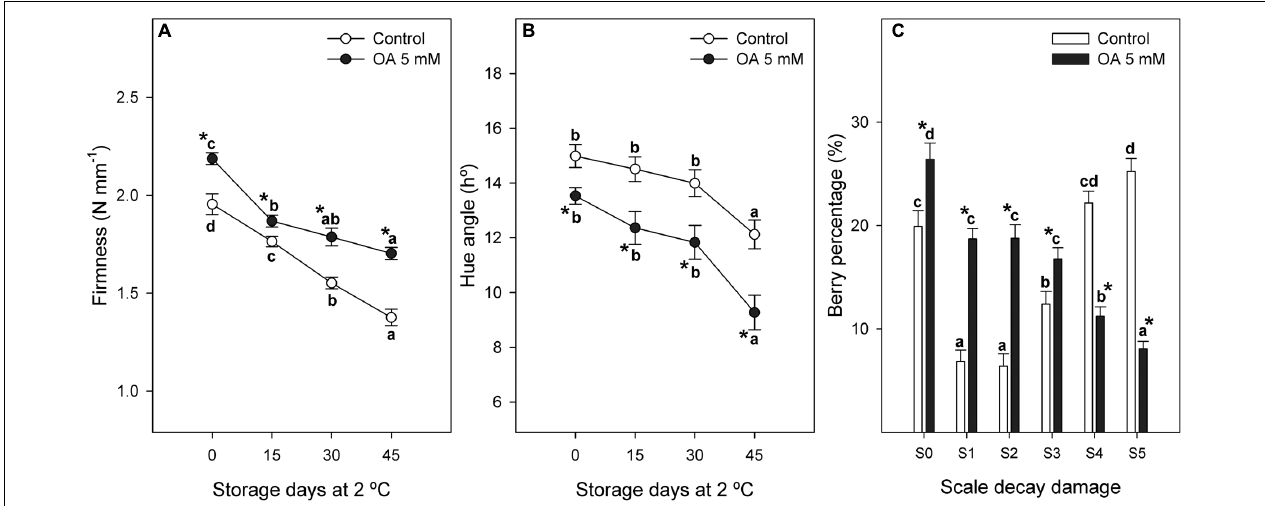
FIGURE 3 | Evolution of firmness [N mm − 1 (A) ] and hue angle colour [h ◦ (B) ] during 45 days of postharvest storage at 2 ◦ C of control and 5 mM OA-treated table grapes. Percentage of decayed berries [% (C) ] according to the visual aspect scale (S0–S5) of Botrytis cinerea decay incidence in ‘Magenta’ table grapes as affected by preharvest treatments with control and oxalic acid (OA). Data are the mean ± SE. Significant differences ( p < 0.05 according to Student’s t -test) between control and OA-treated berries were expressed as * symbol placed in the OA line or bar for each storage day or decay damage stage and parameter. Different lowercase letters show significant differences ( p < 0.05 according to HSD Duncan’s test) among the storage days and decay damage stages in